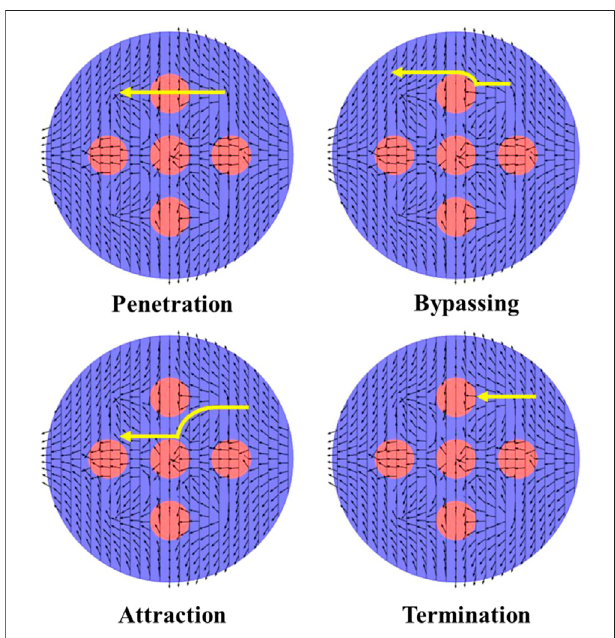
FIGURE 14 | Effects of principal stress reorientation on gravel-hydraulic fracture interaction types. Arrows denote directions of S Hmax and red circles denote